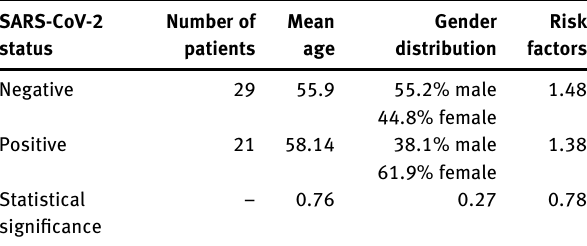
Table  : An overview of differences between the SARS-CoV-  negatively-tested and positively-tested group.